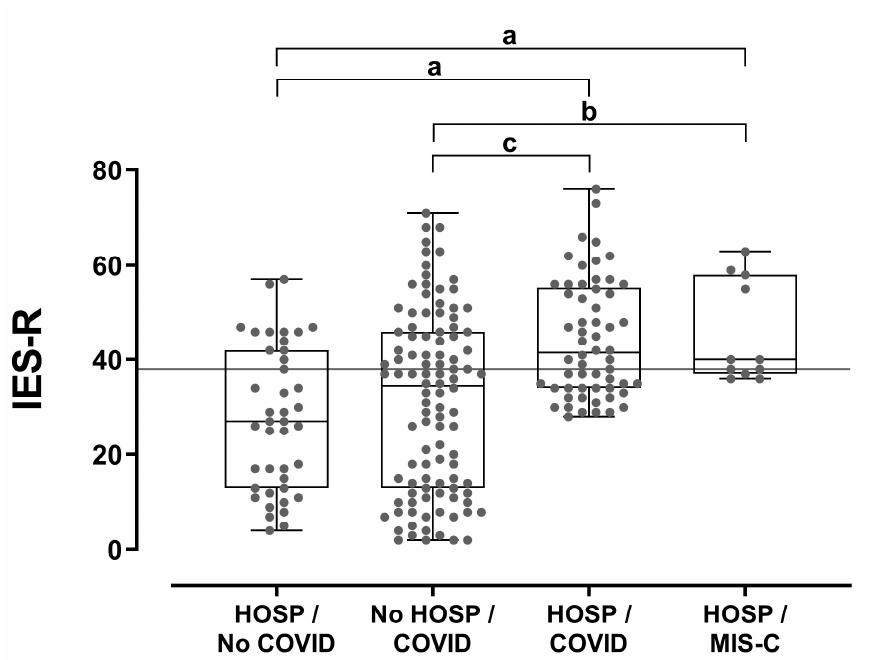
Figure 4. Parental post-traumatic stress levels in relation to hospitalization and COVID-19 status. Between-group comparisons were performed using Kruskal–Wallis and Dunn’s post hoc tests. a: p < 0.001, b: p = 0.021, c: p = 0.032. The horizontal line (IES-R = 38) denotes the diagnostic cut-off for post-traumatic disease. HOSP: hospitalization.